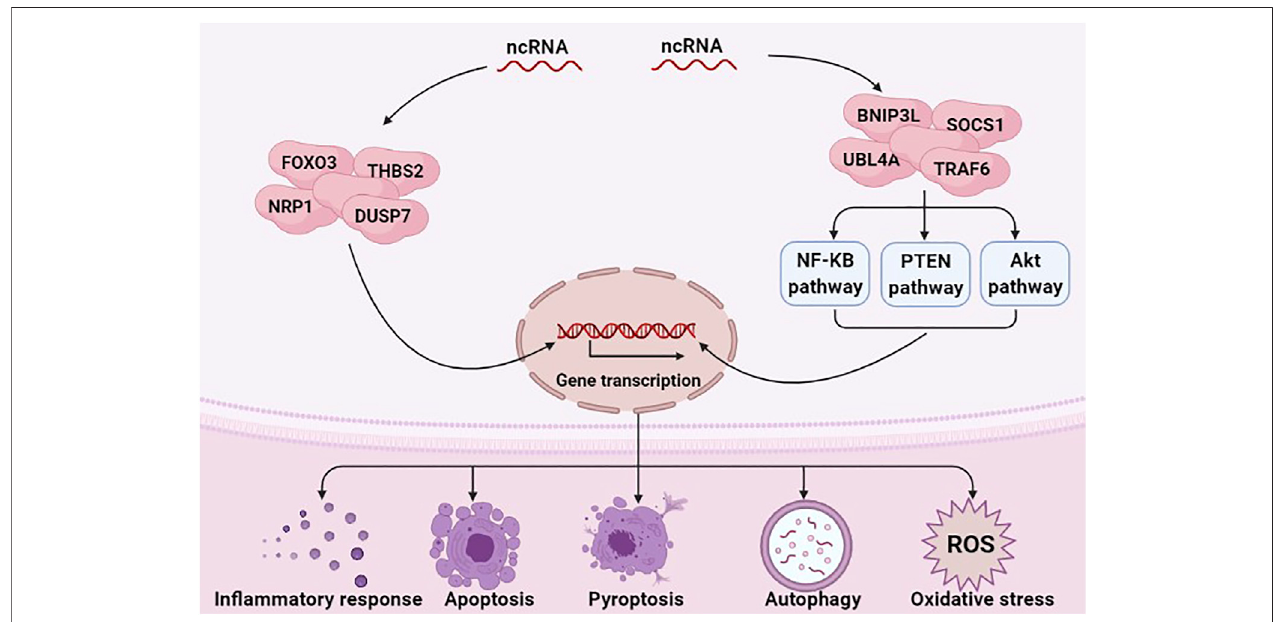
FIGURE 1 | ncRNAs are involved in the pathological mechanism of SA-AKI. ncRNAs, including miRNAs, lncRNAs, and circRNAs, have a critical role in regulating in fl ammation response, programmed cell death, and oxidative stress in SA-AKI by regulating the expression of target genes or regulating various signaling pathways.